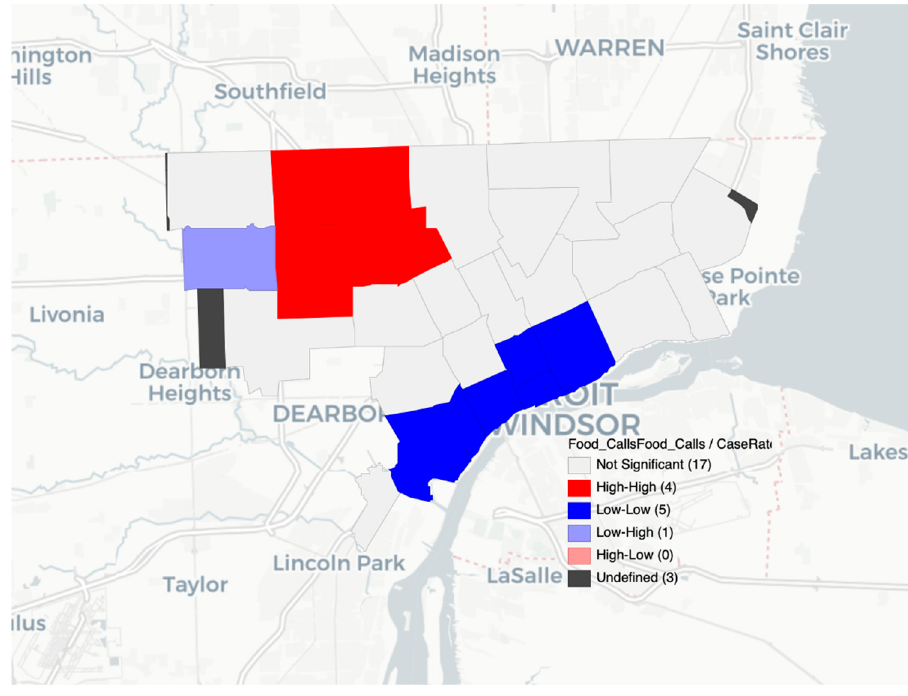
Figure 2. Food assistance calls from 211 and COVID-19 case rates by ZIP code in Detroit.